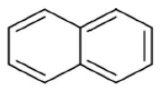
Figure 2. The typical molecule structure of Figure 2 The typical molecule structure of PAHs.